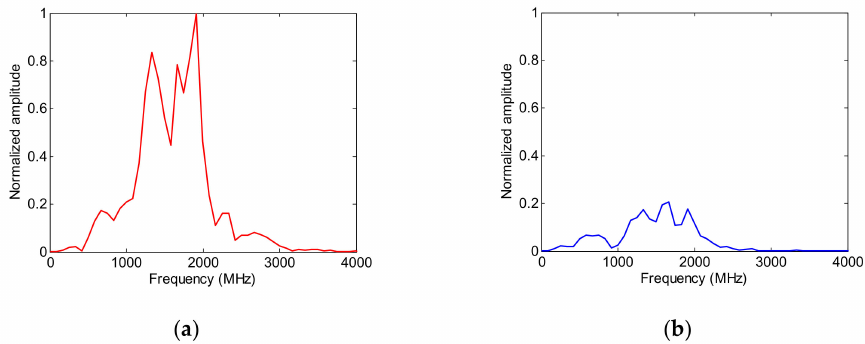
Figure 15. Spectrum of A-scan data: ( a ) disease data, and ( b ) non-disease